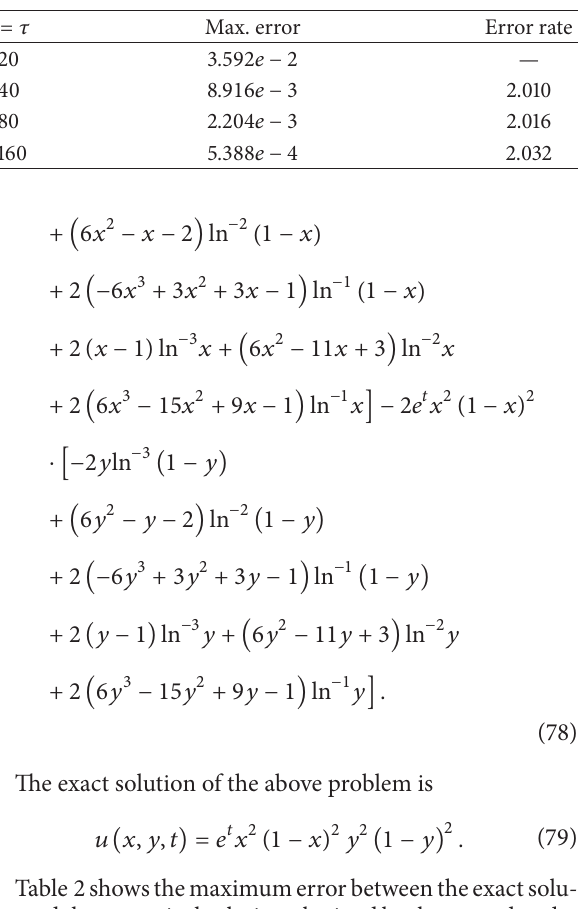
Table 2: The maximum errors for the numerical method and the convergence orders with 𝜎 = 𝜌 = 1/1000 and 𝜏 = ℎ at time 𝑇 = 1 .